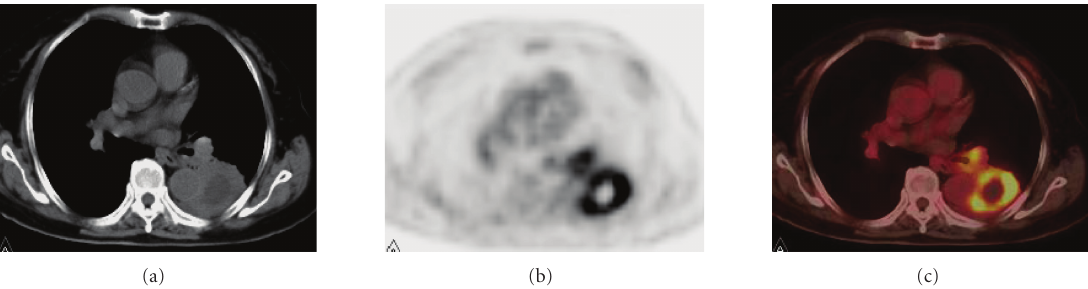
Figure 5: (a), (b), and (c) were from the same patient. The pathology is left lung inflammation. A big mass (5 . 3cm × 5 . 7 cm) with lobulation and spurring was seen on CT (a). Malignant tumor was suspected on CT. False positivity was seen on PET; its early imaging SUVmax is 6.6 (b). The integrated PET/CT also suggested possible lung carcinoma